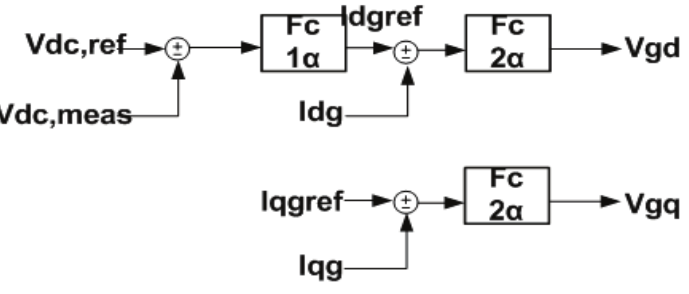
Figure 5. Cgrid control of the DFIG for both study